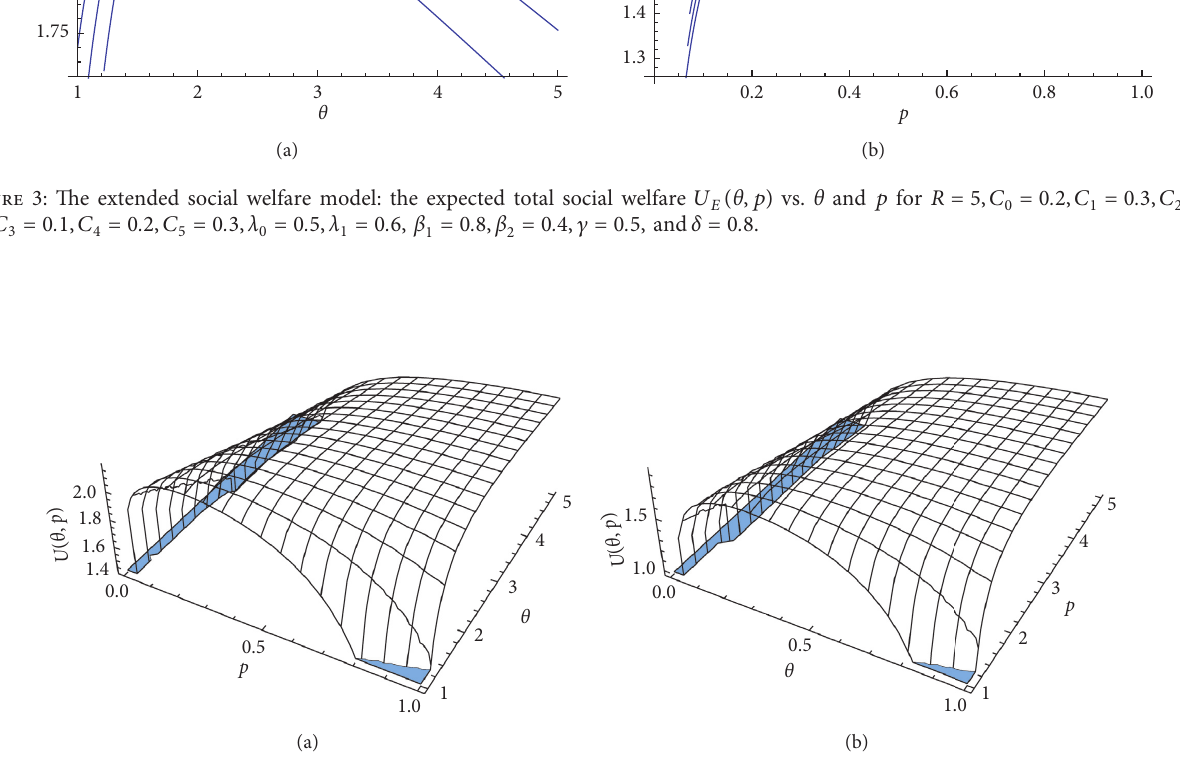
( θ ,p ) , θ , and p for R � 5 ,C i